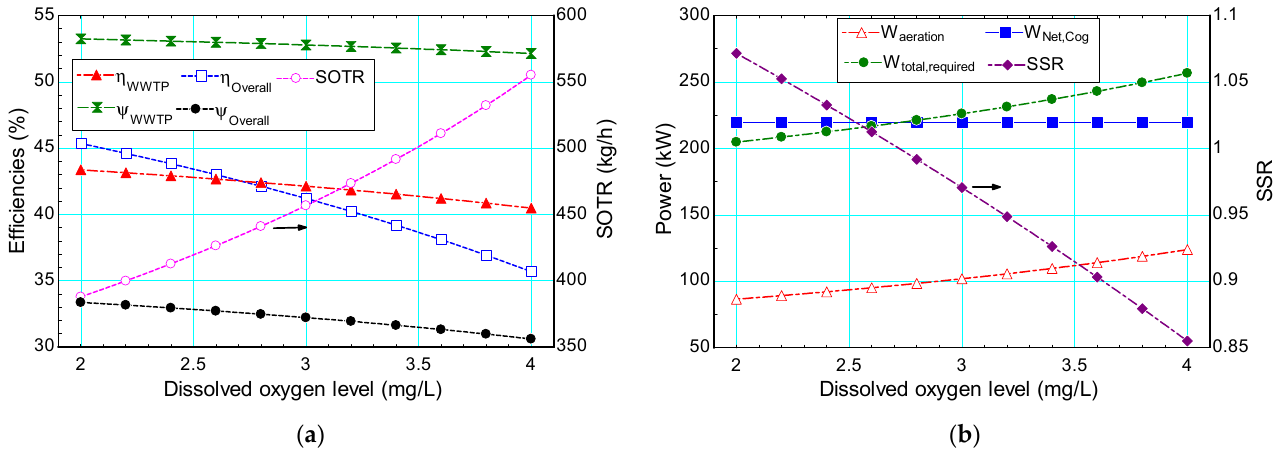
Figure 4. Dissolved oxygen level effect on: ( a ) Efficiencies and SOTR, ( b ) Power requirement and power production.